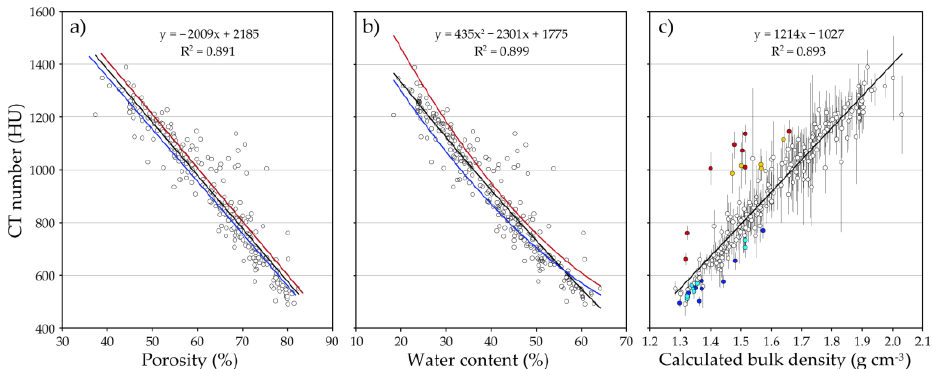
Figure 5. ( a ) Calculated porosity versus measured CT number with the linear regression (black line) explaining 89% of the CT number variability. Blue and red lines depict the linear relations, assuming constant sediment particles’ specific densities of 2.5 and 2.8 g cm −3 , respectively. ( b ) Plot of measured water content against CT number. Polynomial (black line) and linear (not shown) fits to the data points are very similar. Blue and red lines show the expected relations between water content and CT number, calculated using Equation (4) with two particle densities of 2.5 and 2.8 g cm −3 , respectively, and coefficients resulting from CT versus bulk density regression (Figure 5c). ( c ) Calculated bulk density against CT number plotted as dependent variable. Error bars show 1 STD of the mean CT number measured on selected volumes, as described in Section 2.2. Samples with residuals larger than 3 STDs of CT number are filled with red and blue for positive and negative residuals, respectively. Samples with residuals larger than 2 STDs of CT number are filled with orange and light blue for positive and negative residuals, respectively.